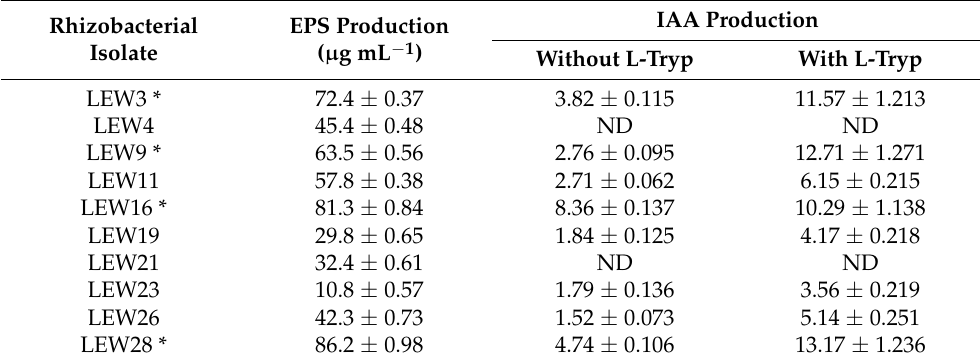
Table 2. Quantitative EPS production and IAA production in the presence and absence of L-tryptophan by rhizobacterial isolates.